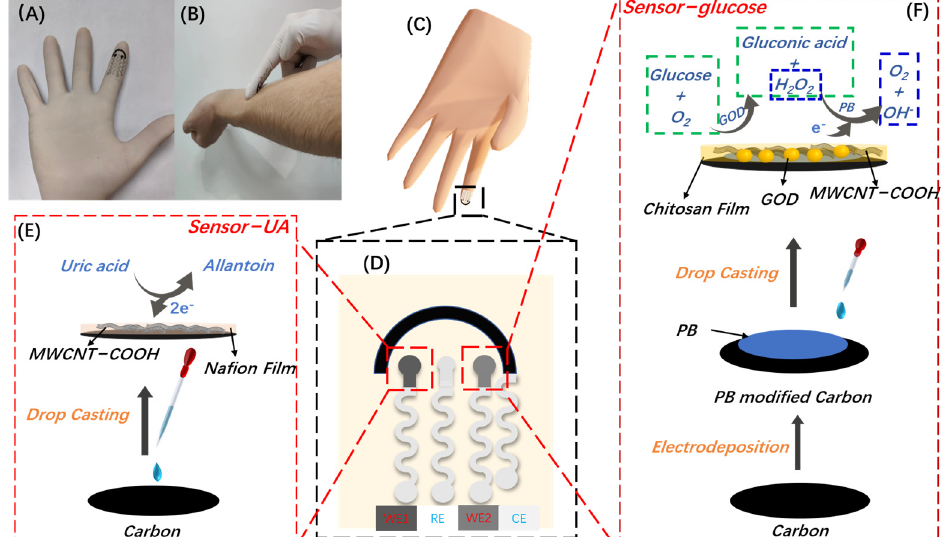
Figure 1. Dual-function electrochemical wearable sensor for glucose and uric acid sensing. ( A ) Optical image of the dual-function wearable electrochemical sensor. ( B ) Optical image of “touch & sense” concept. ( C ) Scheme of the wearable sensor printing on a rubber glove. ( D ) Scheme of the four-electrode sensor. ( E , F ) Schematics of the preparations of Sensor-UA and Sensor-glucose and their sensing mechanism towards UA and glucose, respectively.